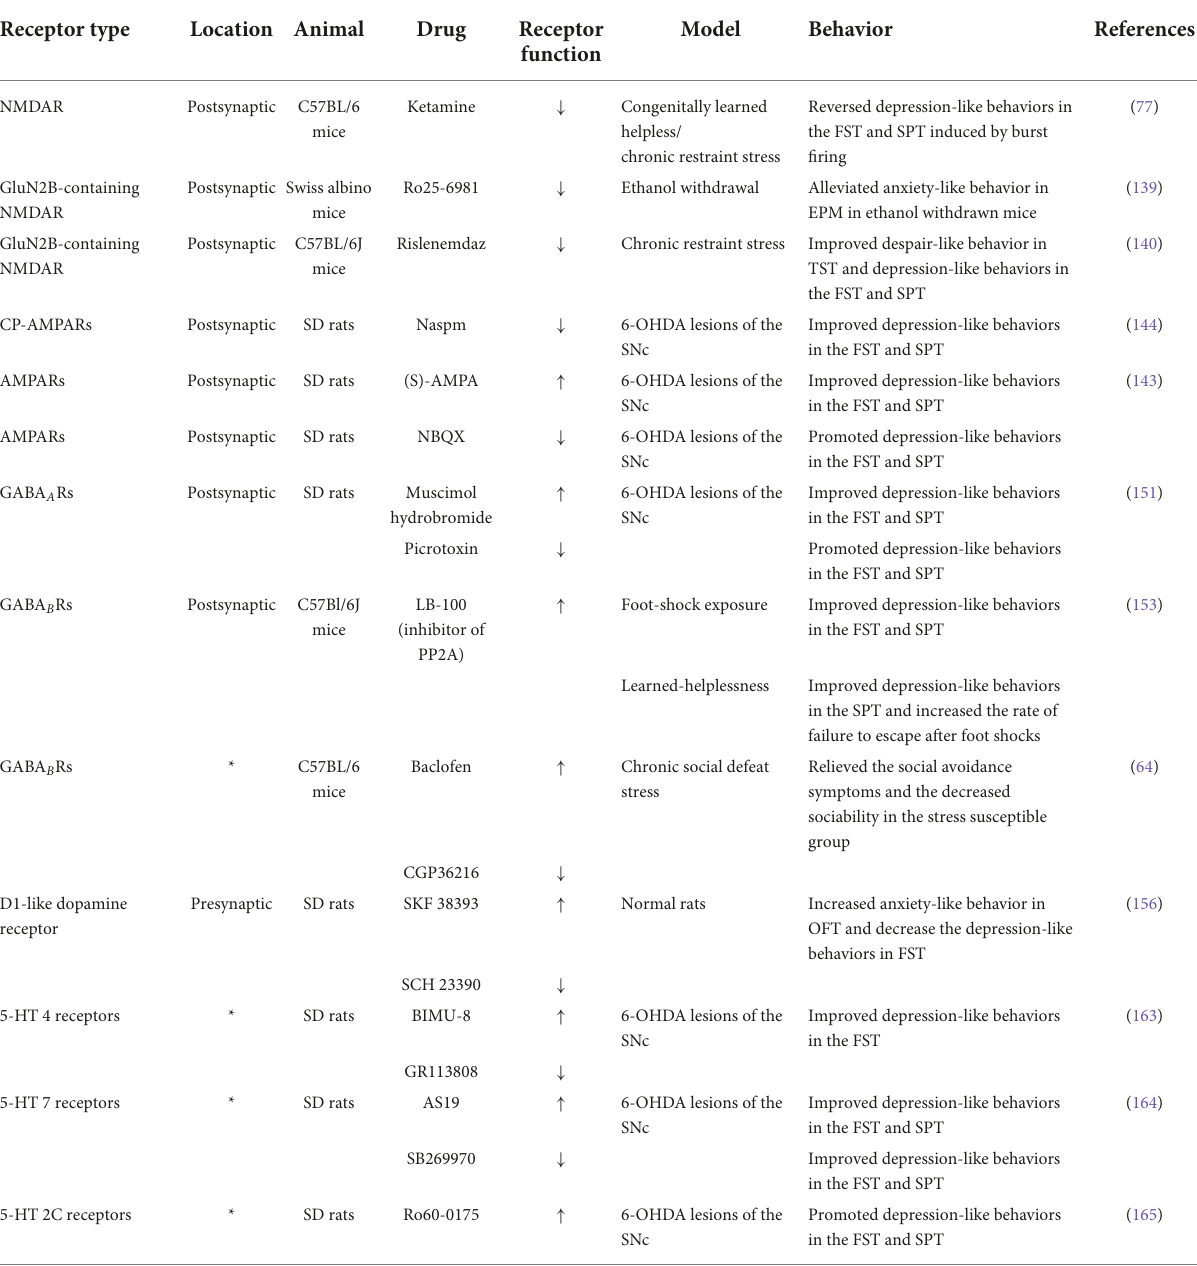
The upregulation and downregulation of receptor functions are indicated by ↑ and ↓ arrows, respectively. An asterisk indicates that the distribution of receptors still ambiguous. FST,